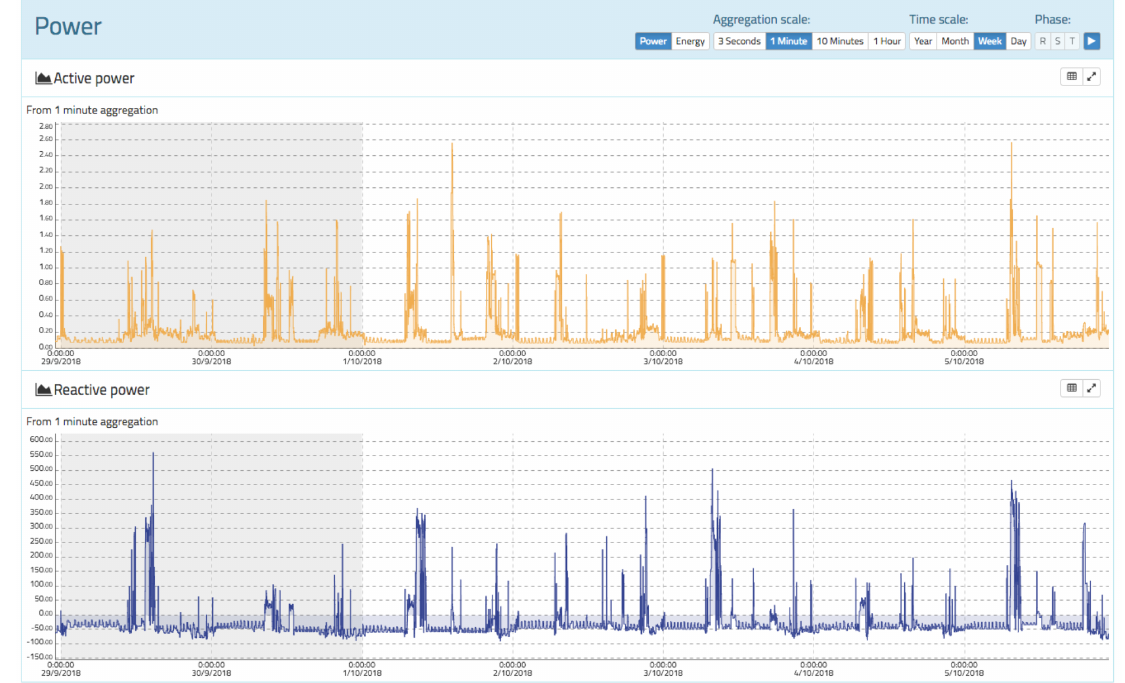
Figure 13. Active and reactive power view of